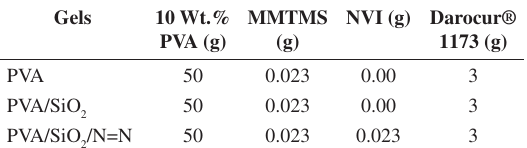
Table 1. The components of raw materials used in the synthesis of nanofiber membranes.